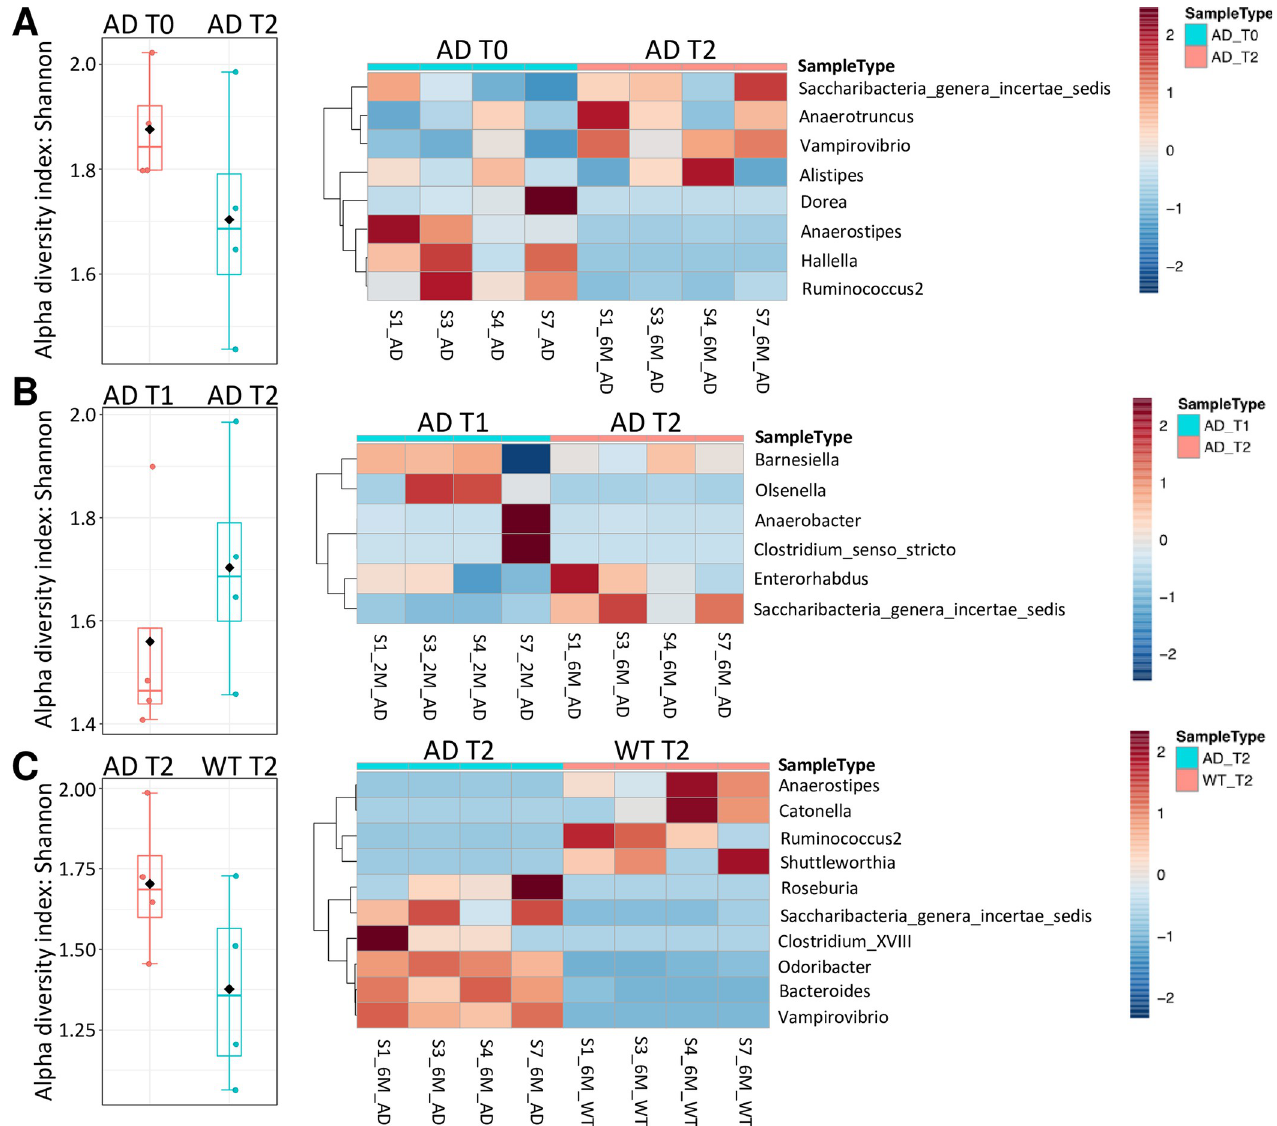
Fig 2. AD progression drives global perturbations in the microbiota. A) Differences at the genus taxonomic rank in mice stool microbiota between T2 and T0 time points, for AD samples. Plots show alpha diversity (Shannon index) for the samples considered and the corresponding heatmap of the differentially modulated genera. B) Differences at the genus taxonomic rank in mice stool microbiota between T1 and T2 time points, for AD samples. Plots show alpha diversity (Shannon index) for the samples considered and the corresponding heatmap of the differentially modulated genera. C) Differences at the genus taxonomic rank in mice stool microbiota between WT samples and AD samples at T2 time points. Plots show alpha diversity (Shannon index) for the samples considered and the corresponding heatmap of the differentially modulated genera.